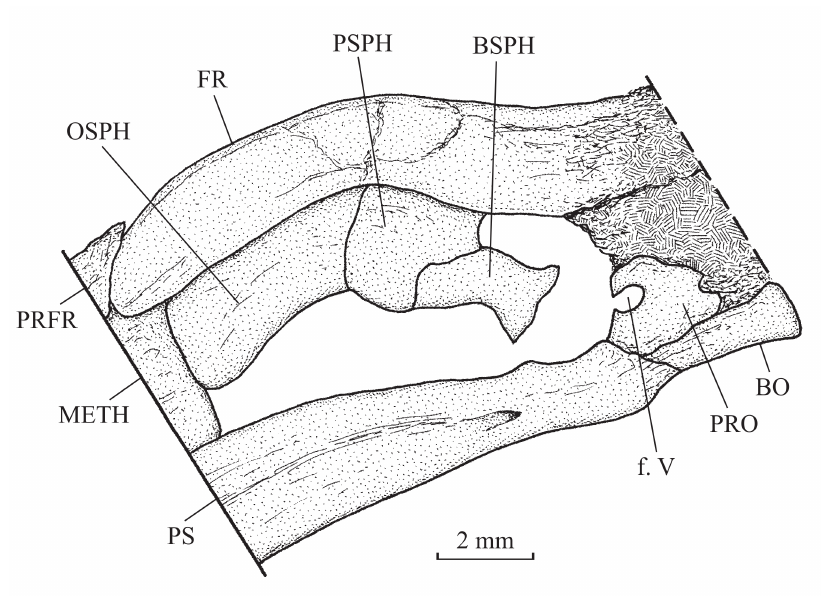
Fig. 8. Joinvillichthys lindstroemi (Davis, 1890). Orbital region of sample IRSNB N° P